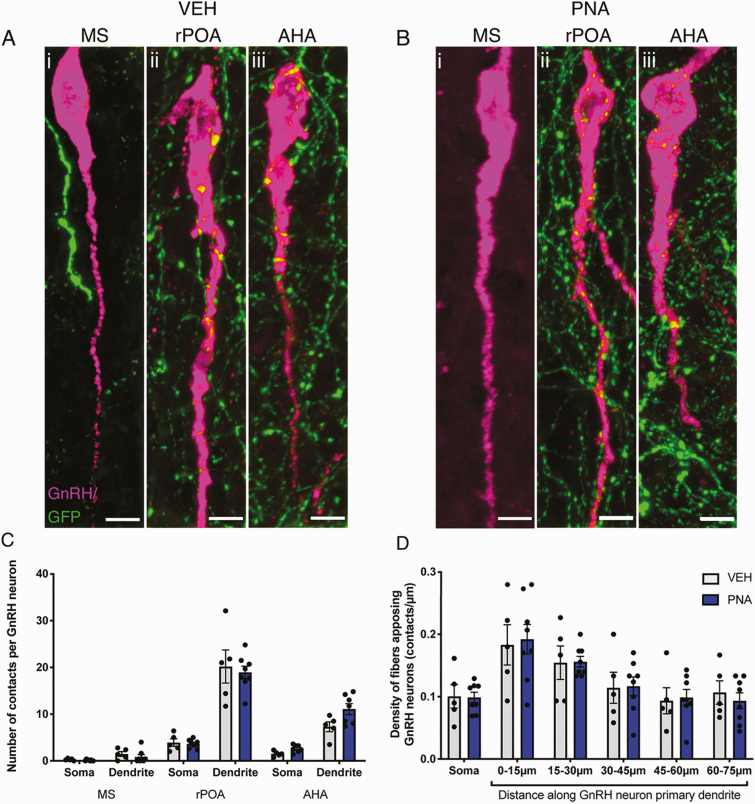

Presence of close appositions between NPY
ARN  neurons and GnRH neurons is region-dependent and not modified by PNA treatment. (A,B) Representative images composed from z-projections (thickness 12-14 µm) of GnRH neurons (magenta) residing in the MS (i), rPOA (ii) and AHA (iii) of VEH- (A) and PNA-treated (B) mice showing GFP-expressing NPYARN fibers (green) in close contact with GnRH neurons. (C) The mean number of contacts per GnRH neuron made by NPYARN neuron fibers to GnRH neurons located in the MS, rPOA, and AHA, at the level of the soma and the primary dendrite in VEH- (gray bars, n = 5) and PNA-treated mice (blue bars, n = 8). (D) The mean density of contacts made onto GnRH neurons in the rPOA by NPYARN fiber projections, at the level of the soma and in 15-µm subsections of the primary dendrite. Results are presented as mean ± SEM. No significant differences were detected by 2-way ANOVA (C) or 1-way ANOVA (D). Scale bars = 5 µm.